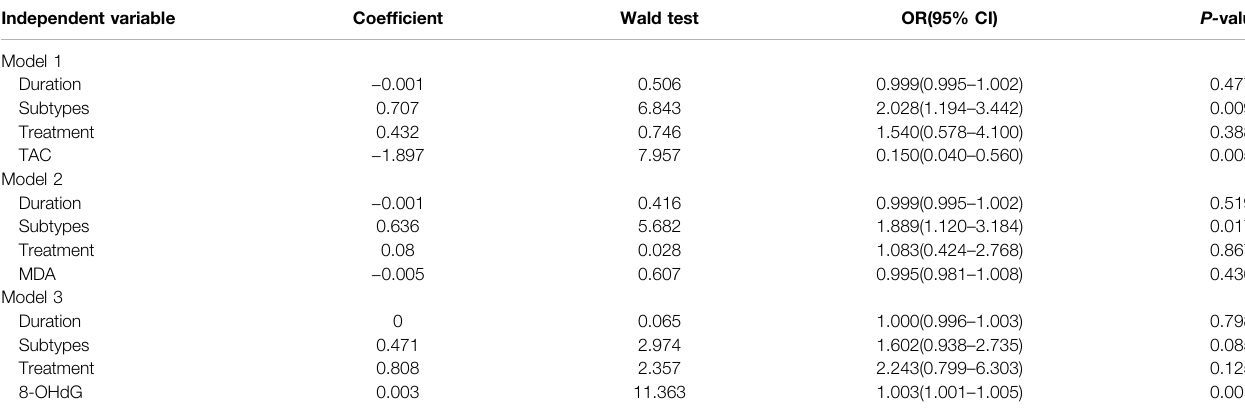
TABLE 5 | Multivariate models investigating the association of TAC, MDA, 8-OHdG, and disease activity. Independent variable